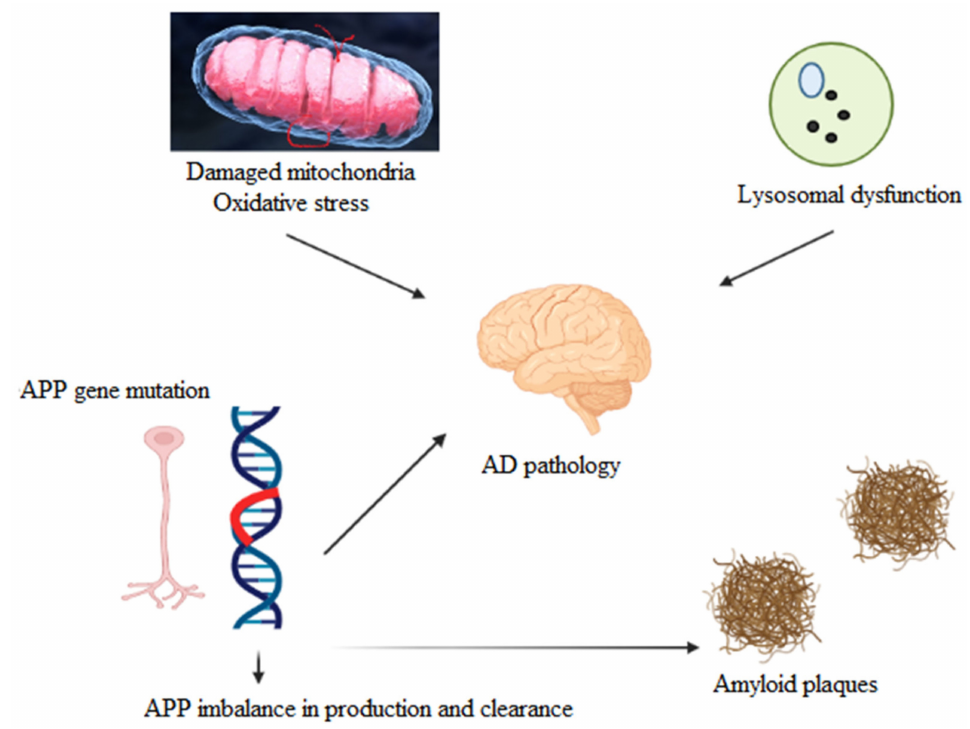
Figure 1. Pathophysiology of Alzheimer’s disease